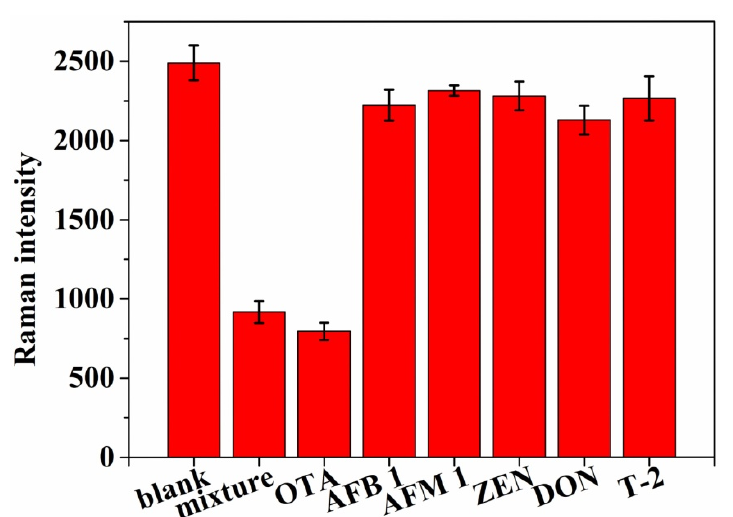
Figure 6. Selectivity evaluation of the ant-interference aptasensor for OTA detection (30 nM) against other mycotoxins (300 nM).